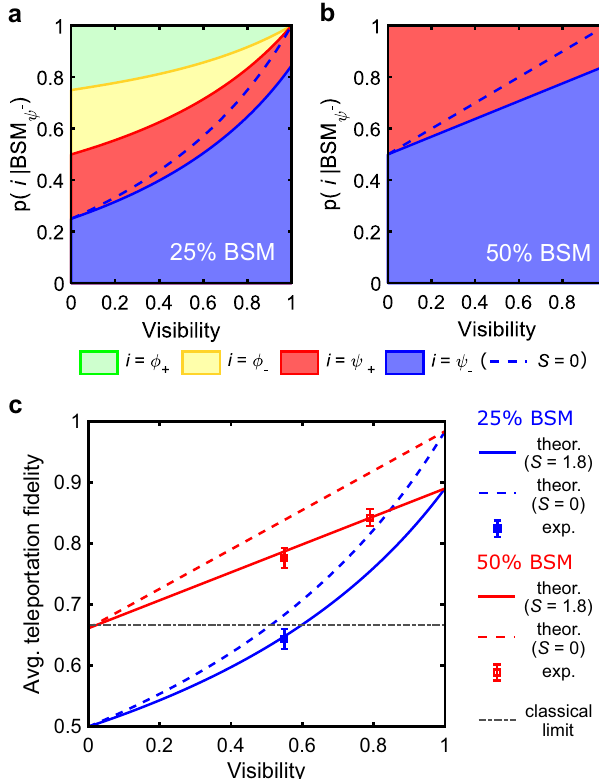
Fig. 5 Modeling with realistic source and setup. a Probabilities that a BSM is caused by two photons in a given Bell state for the 25% ef fi ciency setup, where the detectors at the same output of the non-polarizing beam splitter are grouped together. The probabilities are displayed in a stacked area plot as a function of the HOM visibility and are calculated both with all the physical properties of the investigated QD (solid curve, S = 1.8 eV) and assuming zero FSS (dashed curve). b Same as panel ( a ) but focusing on the BSM of the state ψ (cid:2) j i in the 50% ef fi ciency setup. Identical results apply to the state ψ þ j i by simply swapping the labels between the two states. c Simulated values of the average teleportation fi delity as a function of the HOM visibility for both the implementations of the BSM. Calculated both with all the physical properties of the investigated QD (solid curve, S = 1.8 µeV) and assuming zero FSS (dashed curve). The graph also presents the experimental average fi delities (square dots), including error bars (s.d.), from Fig. 4d for